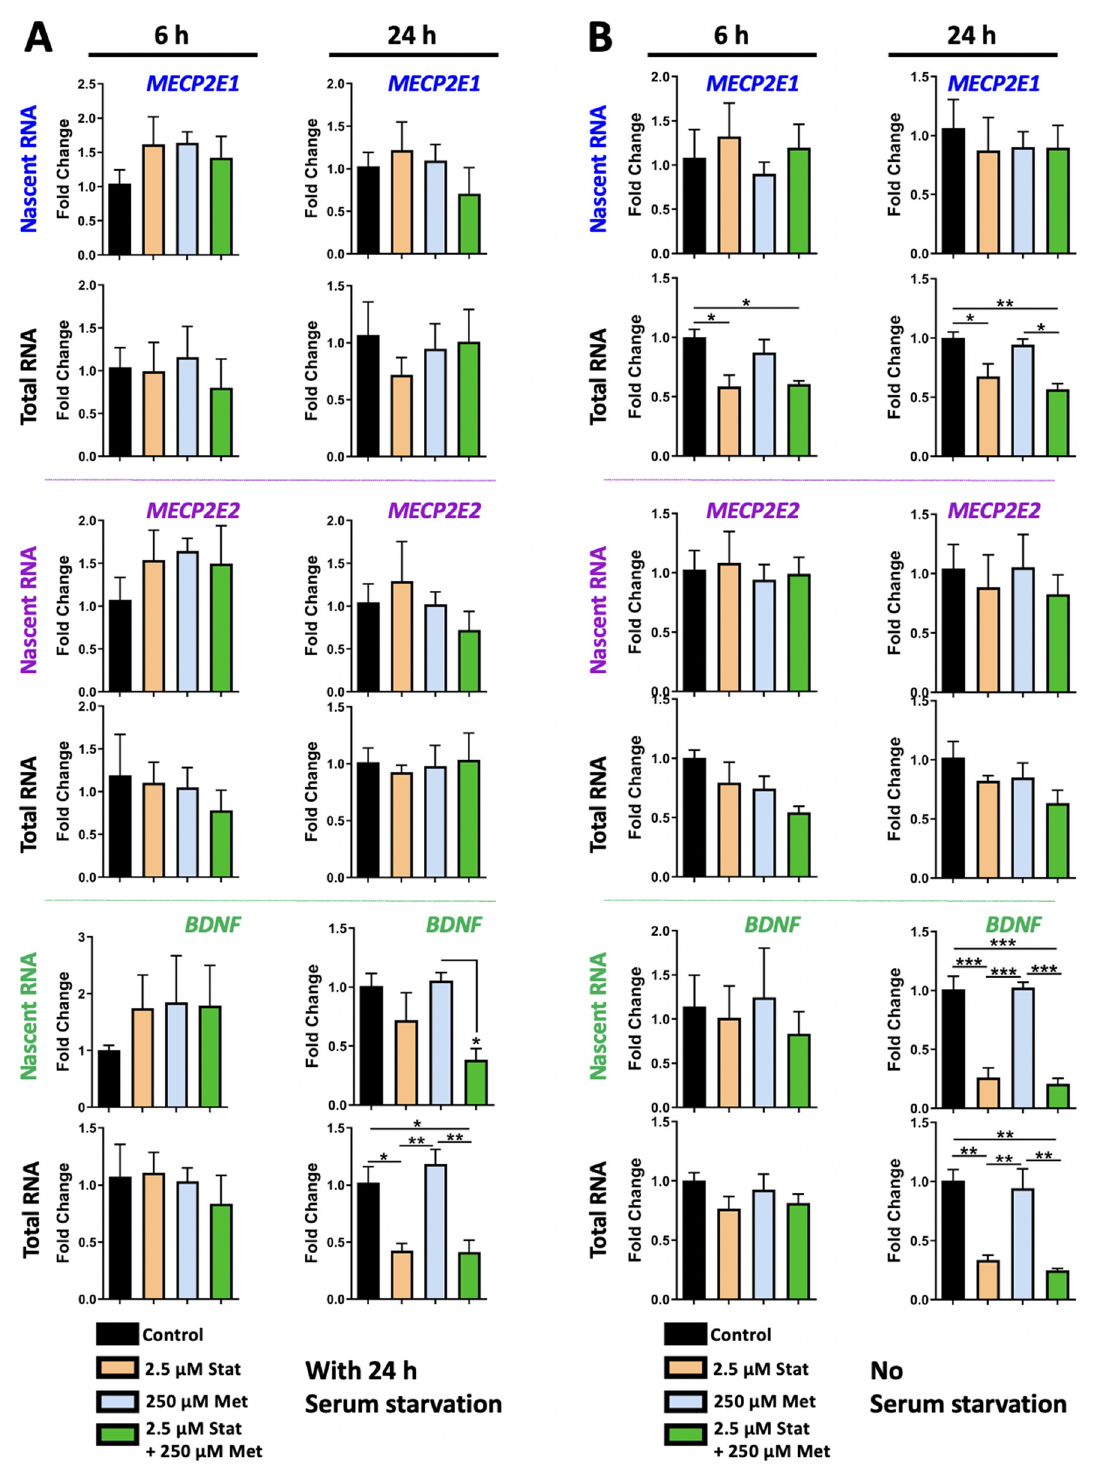
Figure 5. Combined transcriptional effects of simvastatin and metformin on MECP2E1-E2 and BDNF in Daoy cells under the condition with and without serum starvation. ( A ) Daoy cells were serum-starved prior to drug treatment with 2.5 μ M simvastatin (Stat), 250 μ M metformin (Met), and a combination of 2.5 μ M Stat + 250 μ M metformin. Samples were collected at 6 and 24 h and gene transcripts (nascent and steady-state) were analyzed by RT-PCR for MECP2E1 , MECP2E2 , and BDNF . C T values were normalized to the housekeeping gene GAPDH and fold change was determined relative to the average control. N = 3 ± SEM. Fold change values were analyzed by one-way ANOVA followed by Tukey’s multiple comparisons test, * p < 0.05, ** p < 0.01, *** p < 0.001. ( B ) Similar to A, but Daoy cells were subjected to the same drug treatment without prior serum starvation.